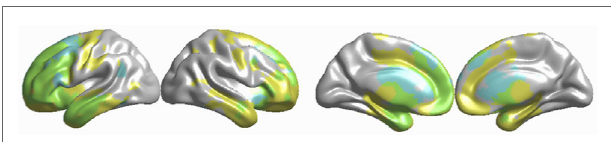
FigUre 3 | Concordance and discordance between brain atrophy and hypoperfusion in amyotrophic lateral sclerosis (ALS)-frontotemporal dementia (FTD) patients. Yellow indicates gray matter (GM) loss in ALS-FTD patients compared with that in healthy control (HC), ALS-Ci, and ALS-Cn; blue indicates cerebral blood flow (CBF) decrease in ALS-FTD patients compared with that in HC, ALS with cognitive impairment (ALS-Ci), and ALS with normal cognition (ALS-Cn); green indicates overlap between GM loss and CBF